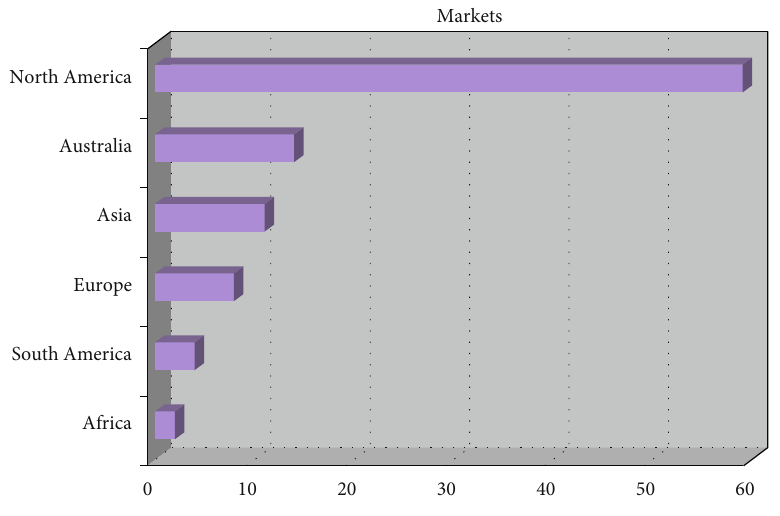
Figure 13: ESG market distribution by